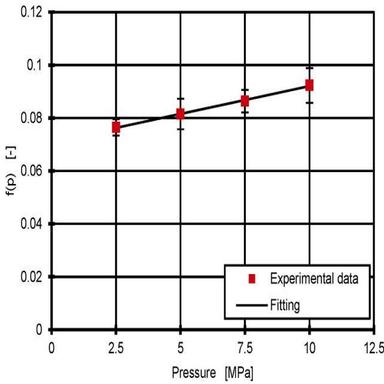
Fitting of the pressure dependent chemical shrinkage for T = 100 ◦C.